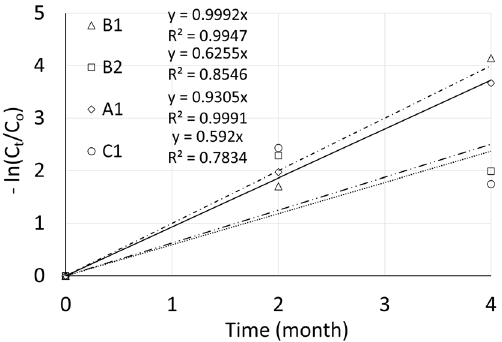
Figure 3. DDTs degradation kinetics. C 0 and C t denote the DDTs concentrations at the beginning of the trial and at time t (month),